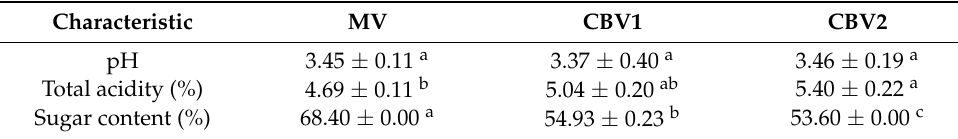
Table 1. Physicochemical characteristics of citrus blend